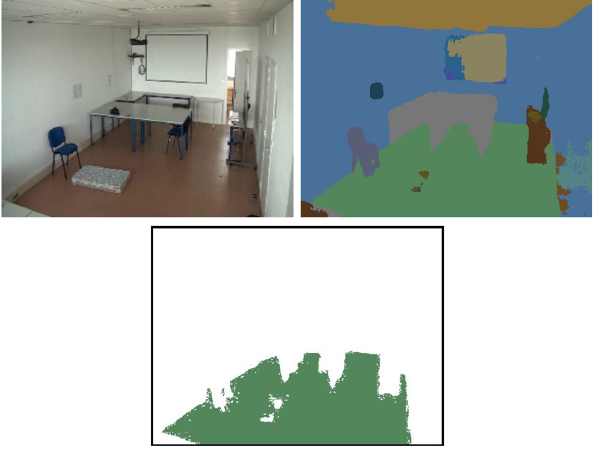
Fig. 5 Floor extraction using the SegNet method. Green pixels correspond to the floor.